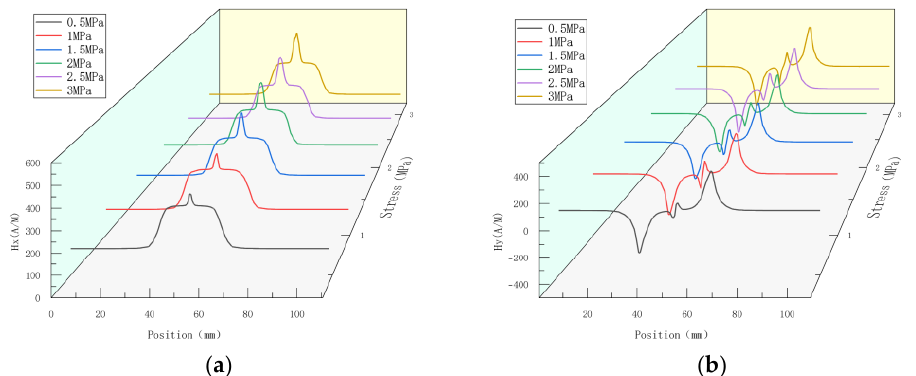
Figure 12. Magnetic signal of weld crack under different internal pressures. ( a ) Axial component of weak magnetic signal; ( b ) radial component of weak magnetic signal.